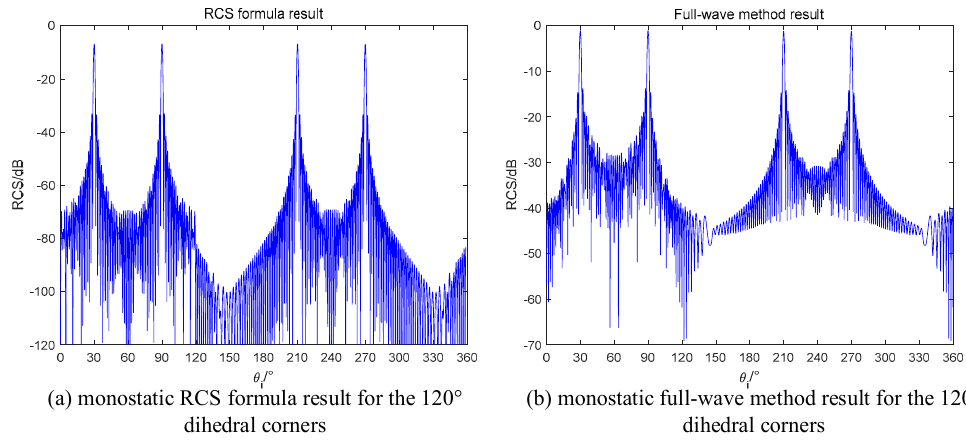
Figure 15. Monostatic RCS of the 120° dihedral ( a ) RCS formula in this paper; ( b ) Full-wave method.